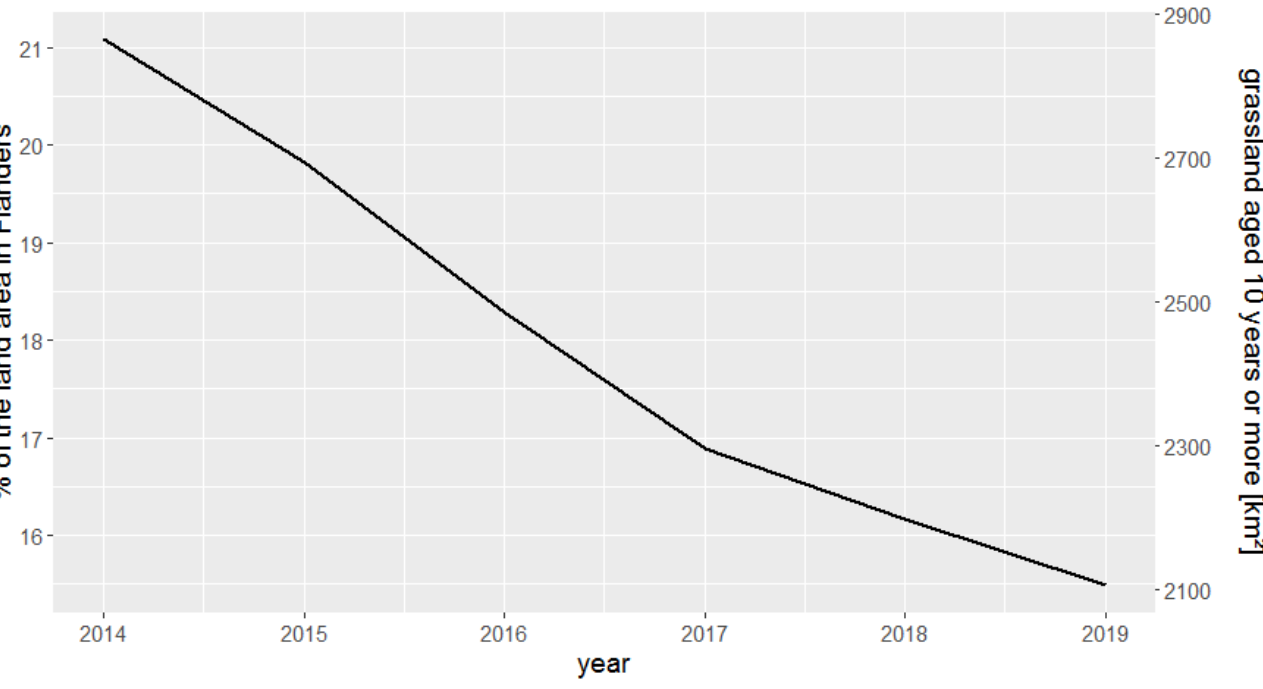
Figure 7. Area of long-term grassland aged 10 years or more from 2014 to 2019 in Flanders, ex- pressed as percentage of Flanders (left axis) and km² (right axis). The area of long-term grassland aged 10 years or more was derived from the historical land cover classification maps from 2005 to 2019.